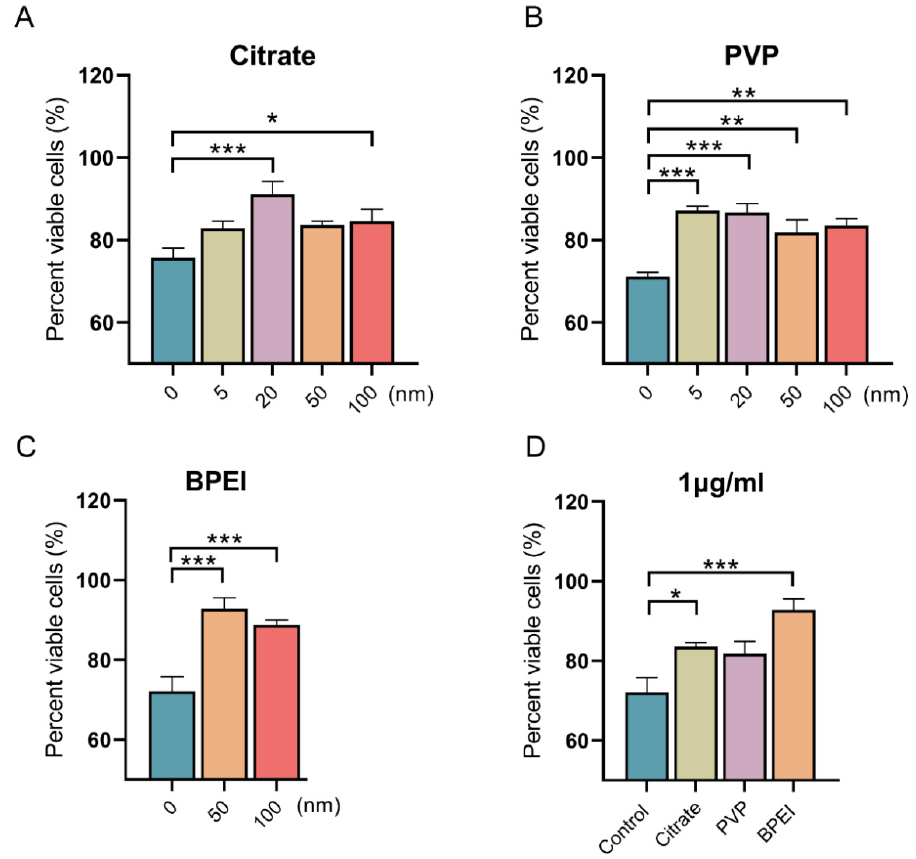
Figure 2. Effects of AgNPs on the viability of Vero E6 cells infected with SARS-CoV-2. Vero E6 cells were infected with SARS-CoV-2 (MOI = 0.008); 1 µg/mL AgNPs-coated with citrate, PVP, or BPEI with different particle sizes were administered for 48 h. ( A – C ) Effects of different particle size materials on the viability of Vero E6 cells infected with SARS-CoV-2, Citrate ( A ), PVP ( B ), BPFI ( C ); ( D ) the viability of Vero E6 cells infected with SARS-CoV-2, treated with 1 µg/mL 50 nm AgNPs; (n = 8 groups), * p < 0.05, ** p < 0.01, *** p < 0.001.